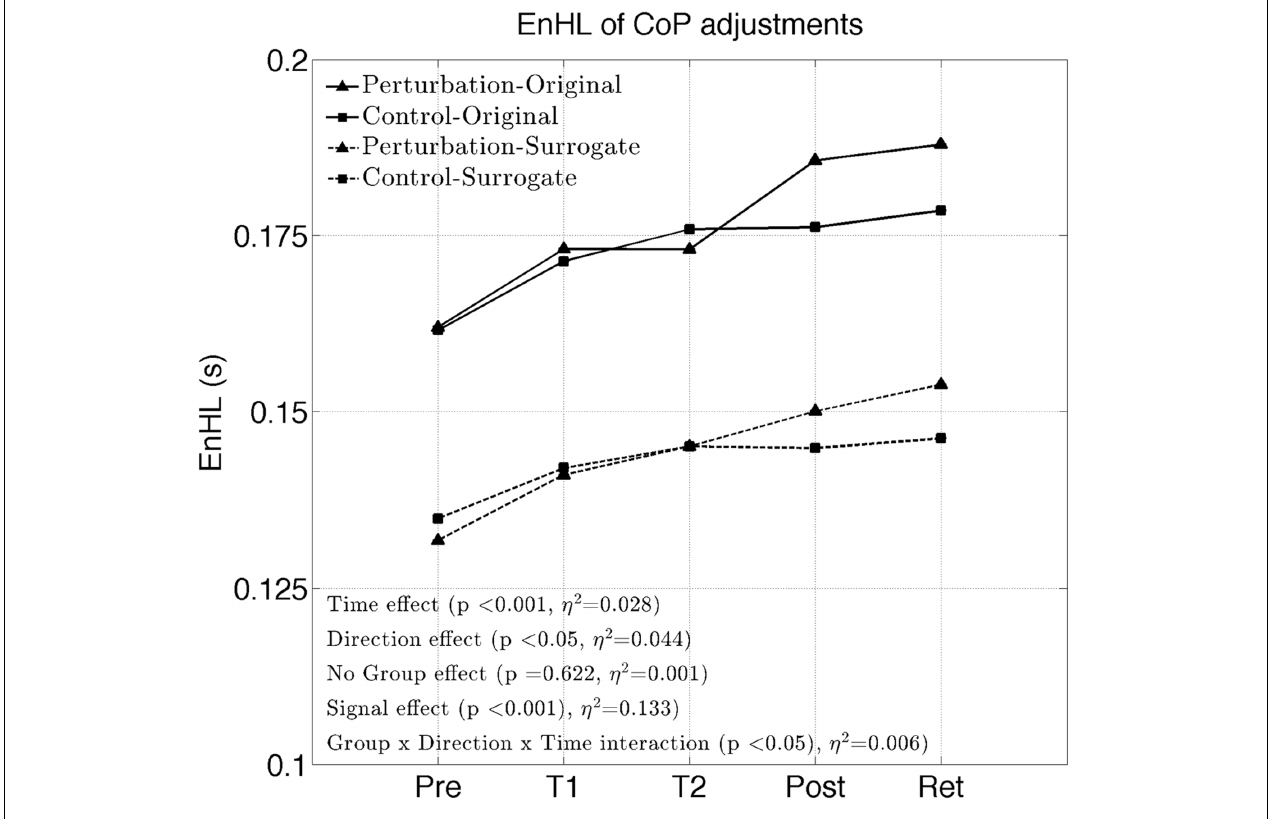
FIGURE 2 | Changes of the EnHL during and after treadmill intervention.